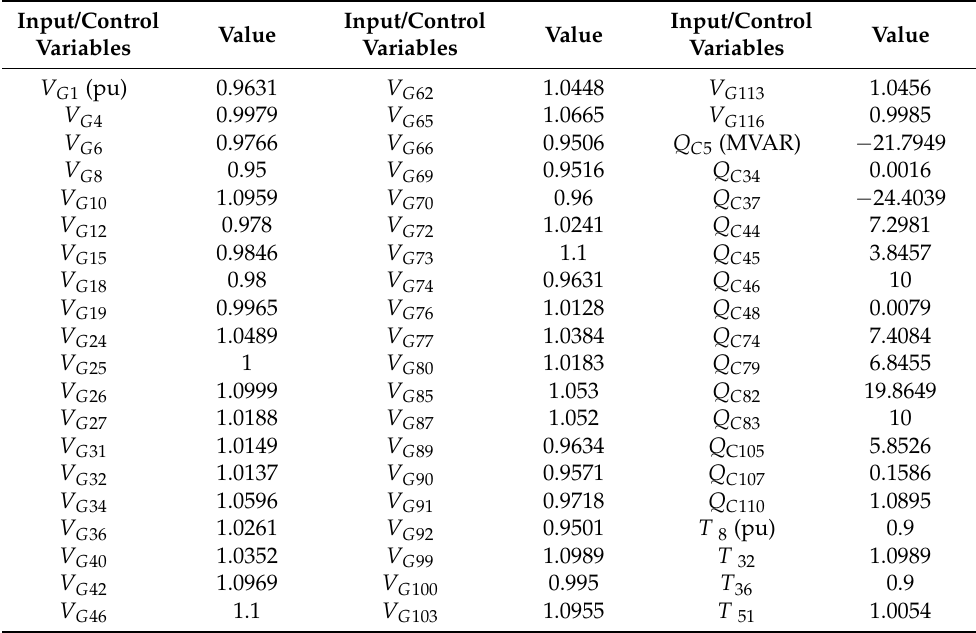
Table A5. Optimal solution obtained by ICOA for L index objective of the IEEE 118-bus power system with the case of continuous